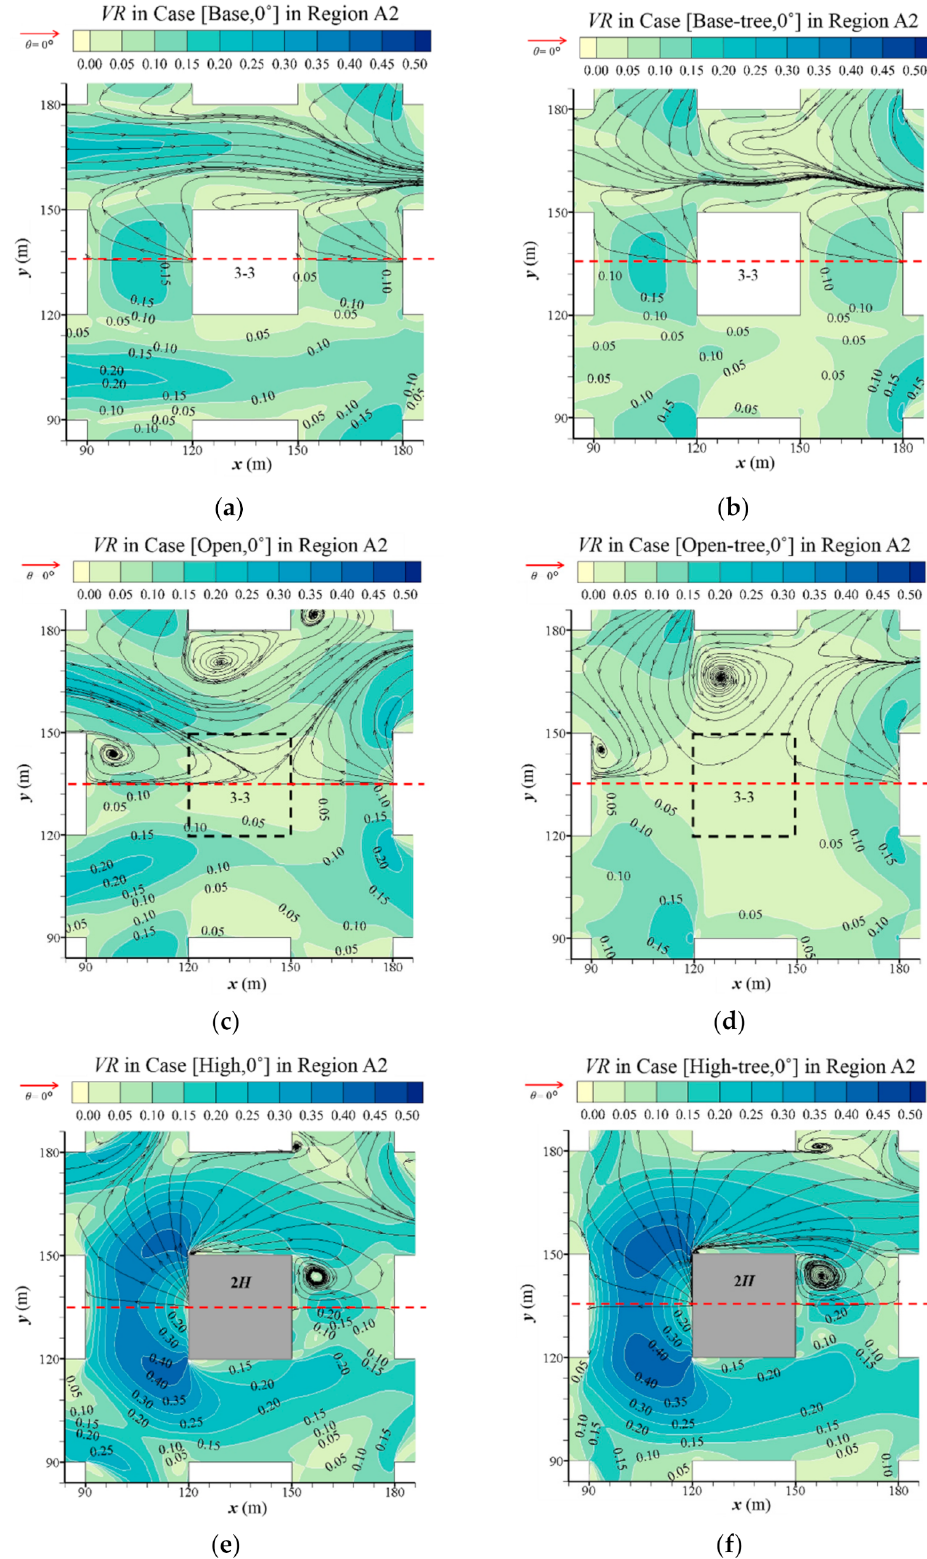
Figure 3. Streamline and velocity ratio ( VR ) at z = 2m in Region A2 in ( a ) Case [Base, 0 ◦ ], ( b ) Case [Base-tree, 0 ◦ ], ( c ) Case [Open, 0 ◦ ], ( d ) Case [Open-tree, 0 ◦ ], ( e ) Case [High, 0 ◦ ] and ( f ) Case [High-tree, 0 ◦